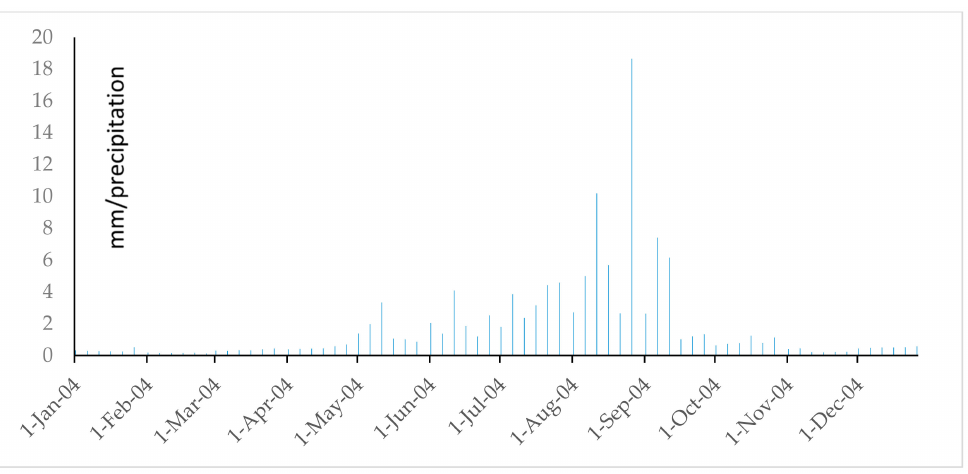
Figure A32. Precipitation of Denko County in 2004.